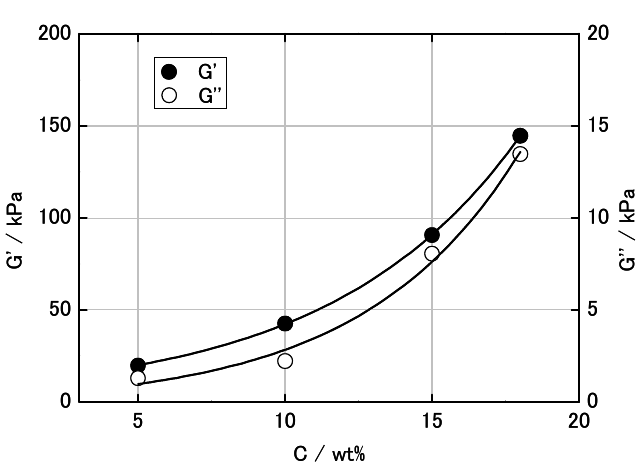
Figure 3 Dynamic viscoelasticity of PVA-H obtained by using P17F with various C